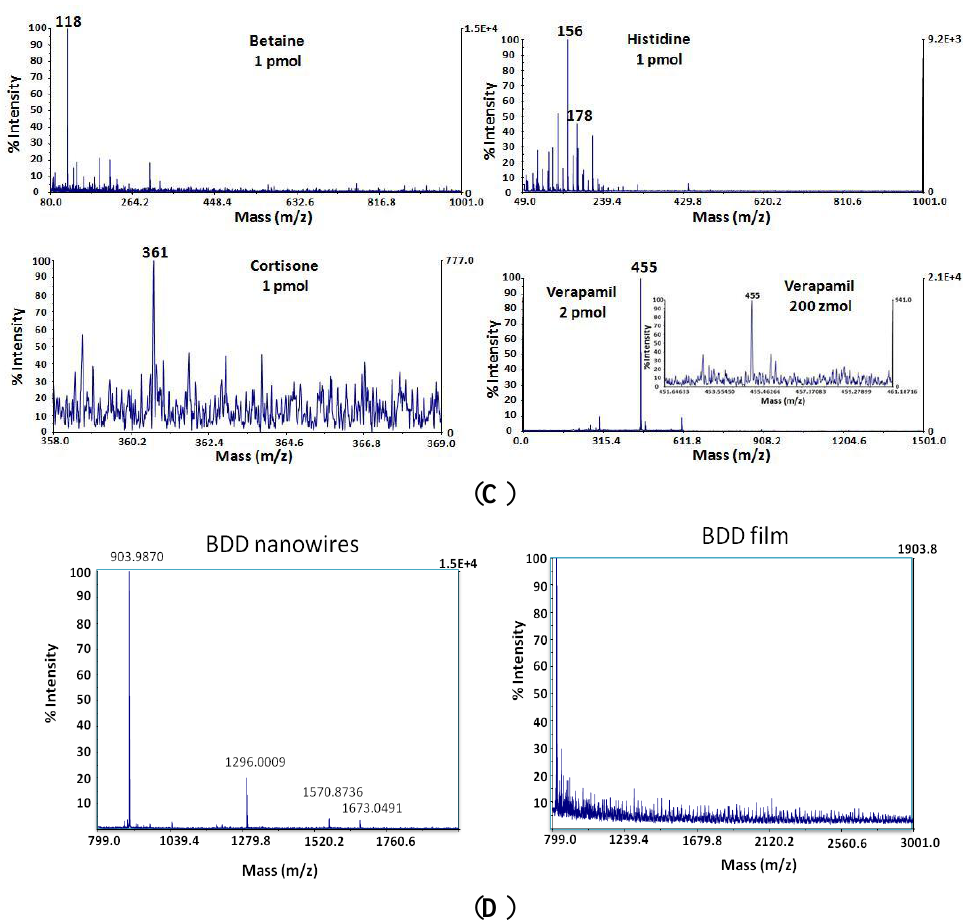
Figure 11. Diamond nanowires as inorganic matrices for SALDI. ( A ) Schematic presentation of the principle of surface-assisted laser desorption/ionization mass spectrometry (SALDI-MS) with analyte deposition on SALDI based nanostructures such as diamond nanowires; ( B ) OTS modified diamond nanowires ( a ) and contact angle values before and after UV/O 3 treatment ( b ); ( C ) LDI-MS spectra on BDD NWs of various compounds (Histidine, m / z 156, 1 pmol; Betaine m/z 118, 1 pmol; Cortisone m/z 361, 1 pmol and verapamil m/z 455, 2 pmol and 200 zmol (inset)); ( D ) LDI-MS detection of a peptide mixture (10 fmol/µL)) on BDD NWs and BDD films (reprint with permission from